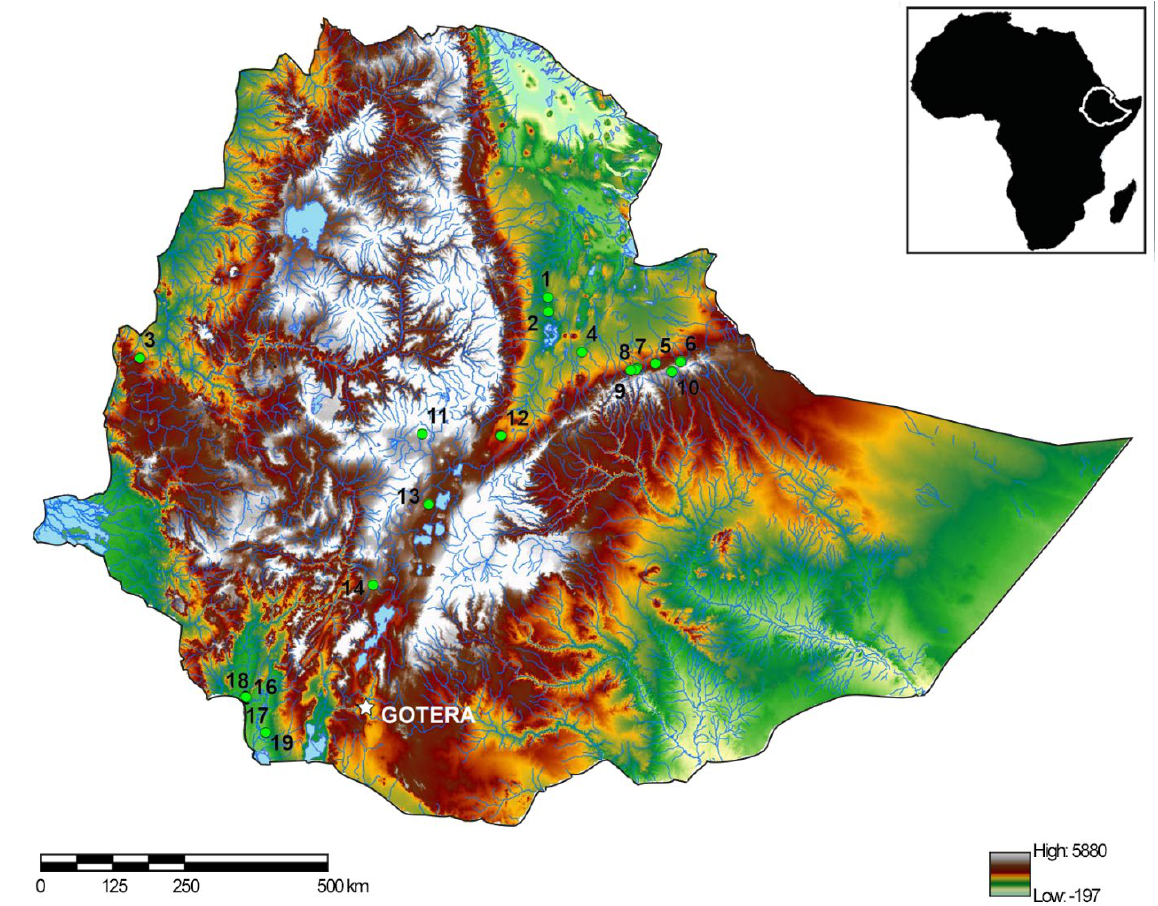
Figure 1. Map of Ethiopia with main MSA sites and location of Gotera area: 1 Bodo; 2 Ardu; 3 Bel ash-Saharifu; 4 Aladi Springs; 5 Porc-Epic; 6 Goda Dubetta; 7 Goda Buticha; 8 Goda Dessa; 9 Gilbo Tate; 10 Goda Wonji; 11 Melka Kunture; 12 Kone; 13 Gademotta; 14 Mochena Borago; 15-19 Omo